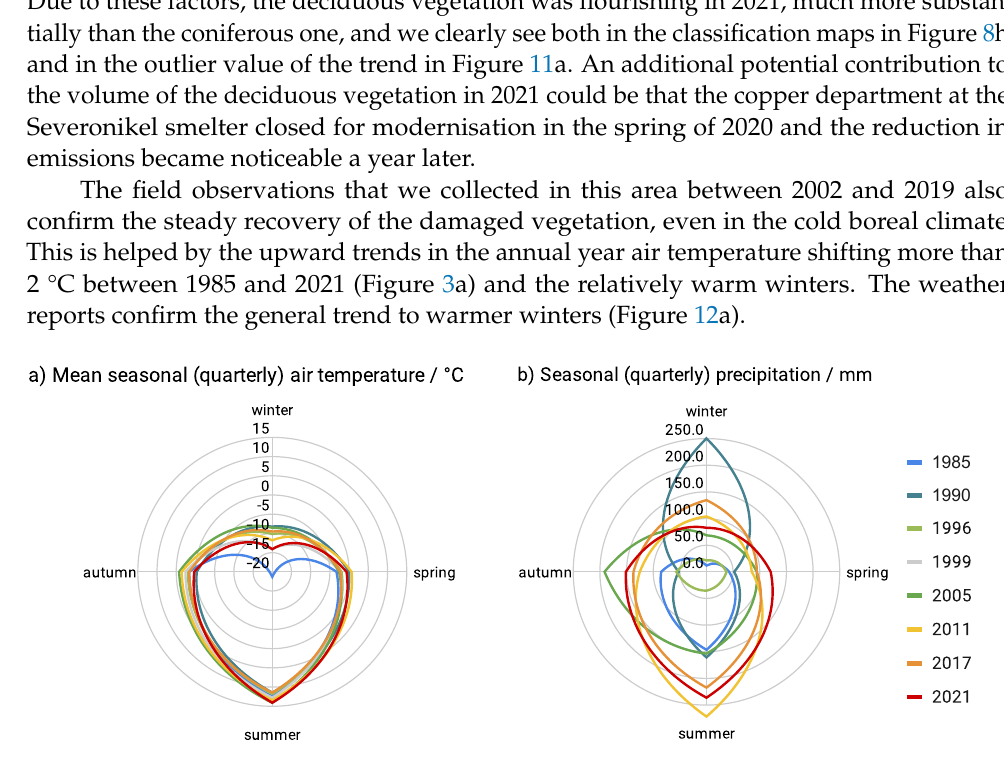
Figure 12. Distribution of ( a ) mean seasonal (quarterly) temperature [30] and ( b ) seasonal (quarterly) precipitation [31] by year. Precipitation data for 1999 are only available for some months [74]; thus, a total value could not be